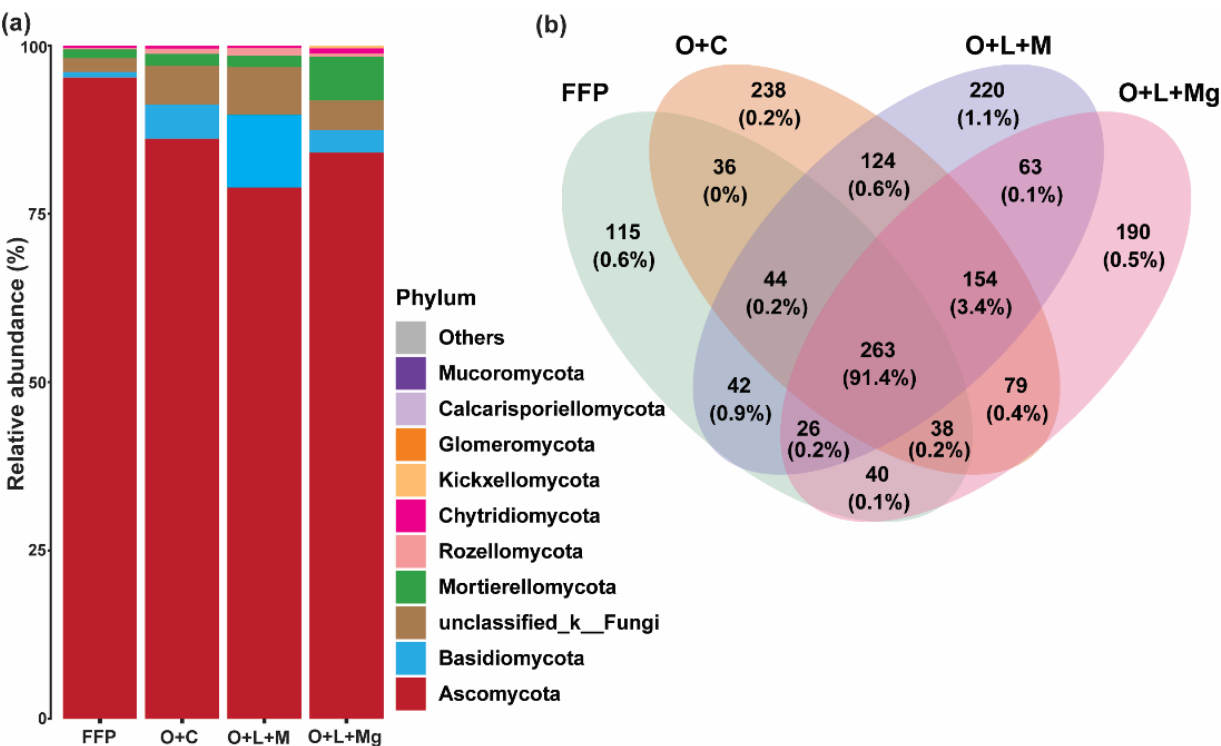
Figure 2. Relative abundance of soil fungal communities. The relative abundance of dominant soil fungal community in different treatments: ( a ) phylum level; ( b ) comparison of different soil fungal community richness. The relative abundance of the top 10 phyla is shown, while less abundant and unclassified phyla are represented by “others”.